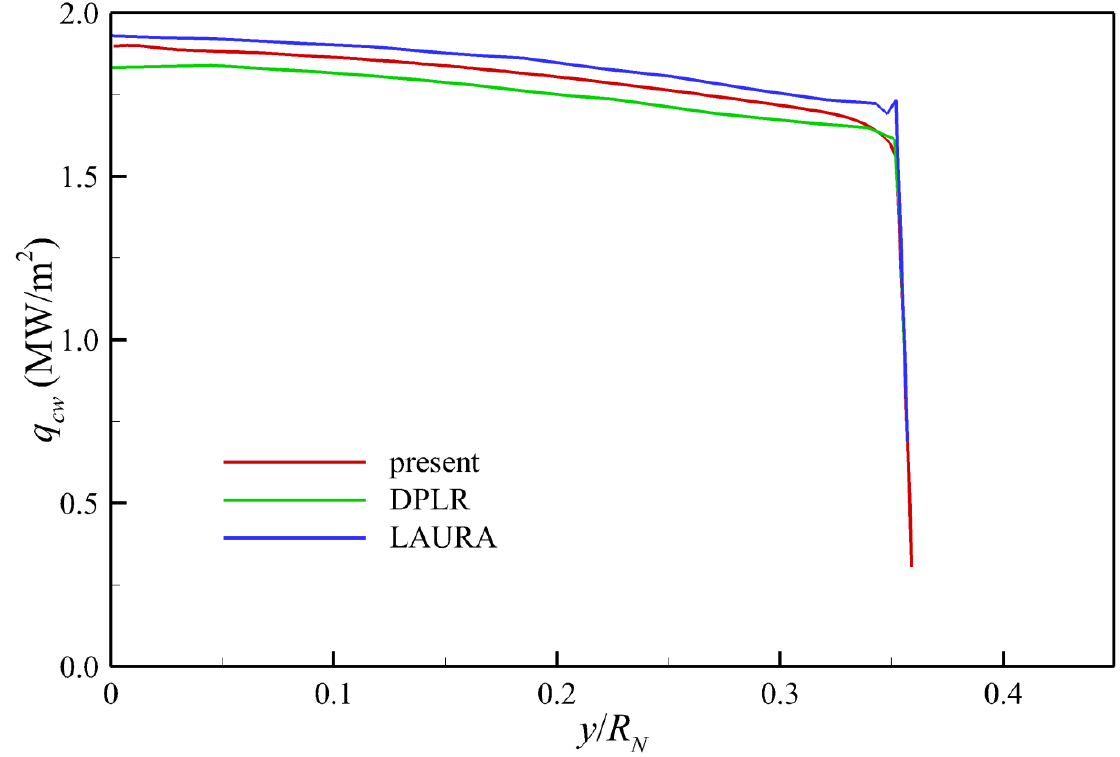
Figure 4. Forebody convective heating at t = 1636 s predicted by the present algorithm (present), DPLR, and LAURA codes.